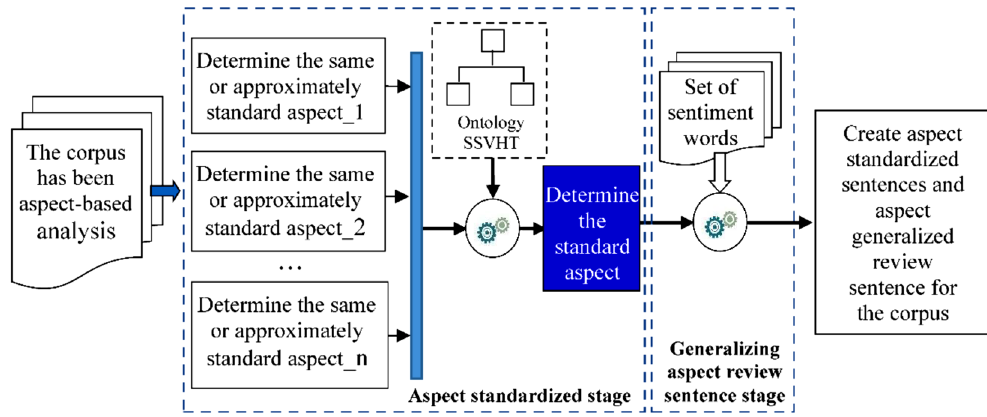
Figure 2. The model embeds knowledge in the corpus.